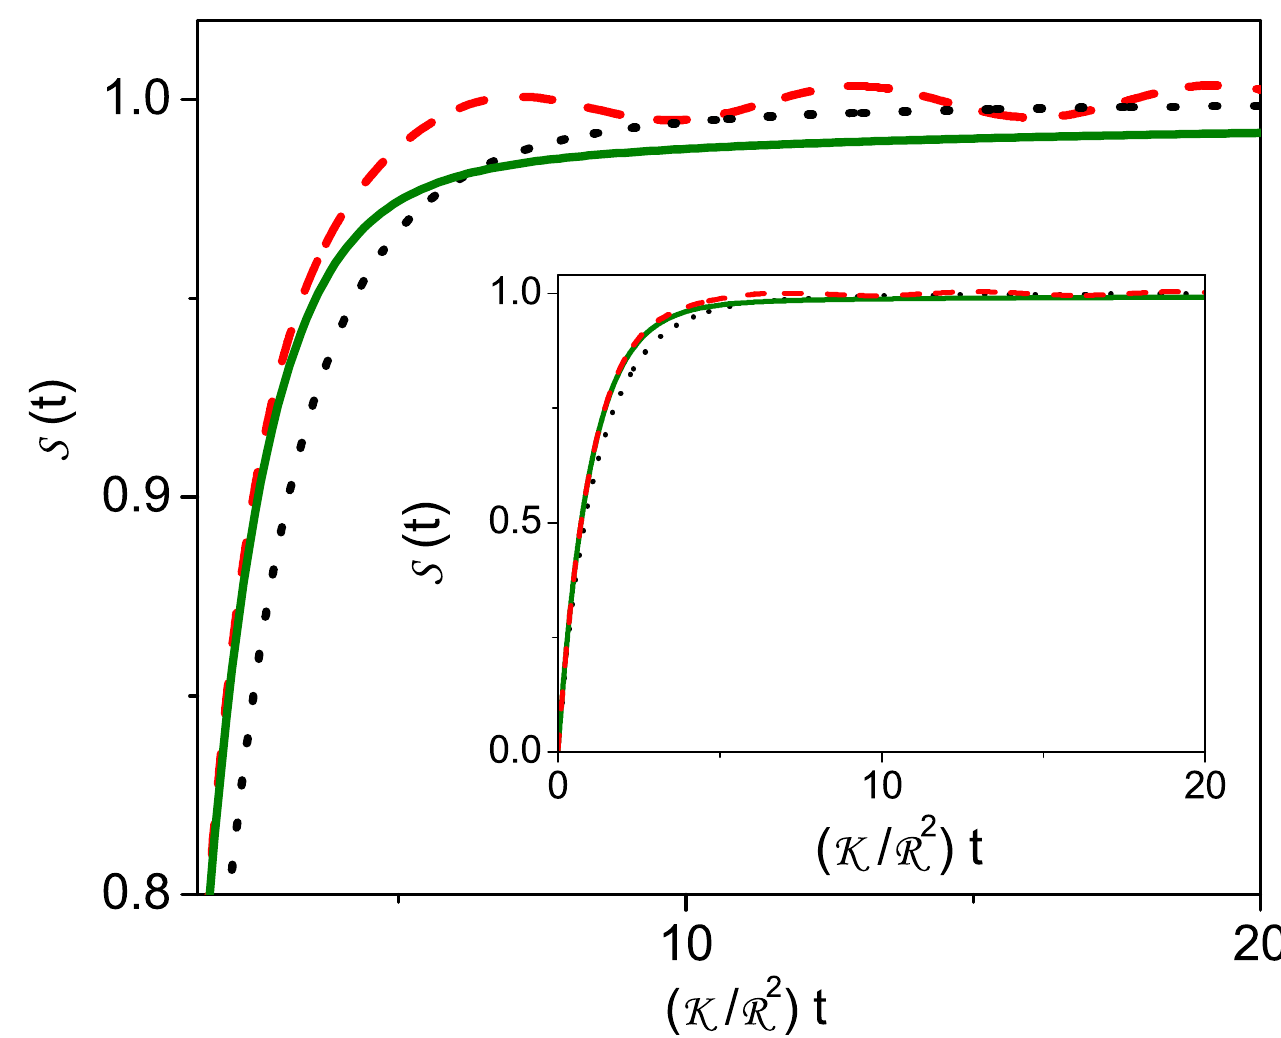
Fig 2. Illustration of a desorption process. This figure illustrates a desorption process characterized by the initial condition C bulk ( r ,0) = 0 and C surf (0) = 1 with